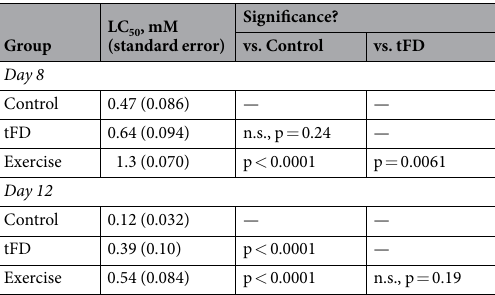
Table 1. LC 50 values after 24-hour exposure to sodium arsenite. Animals were subjected to twice-daily 90 min swim exercise beginning at young adult and continuing for 6 days. Lethality was tested on day 8 (the day after ceasing swim exercise) and on day 12. Significance was determined by pairwise comparison of the nonlinear LC 50 fits using the extra sum-of-squares F